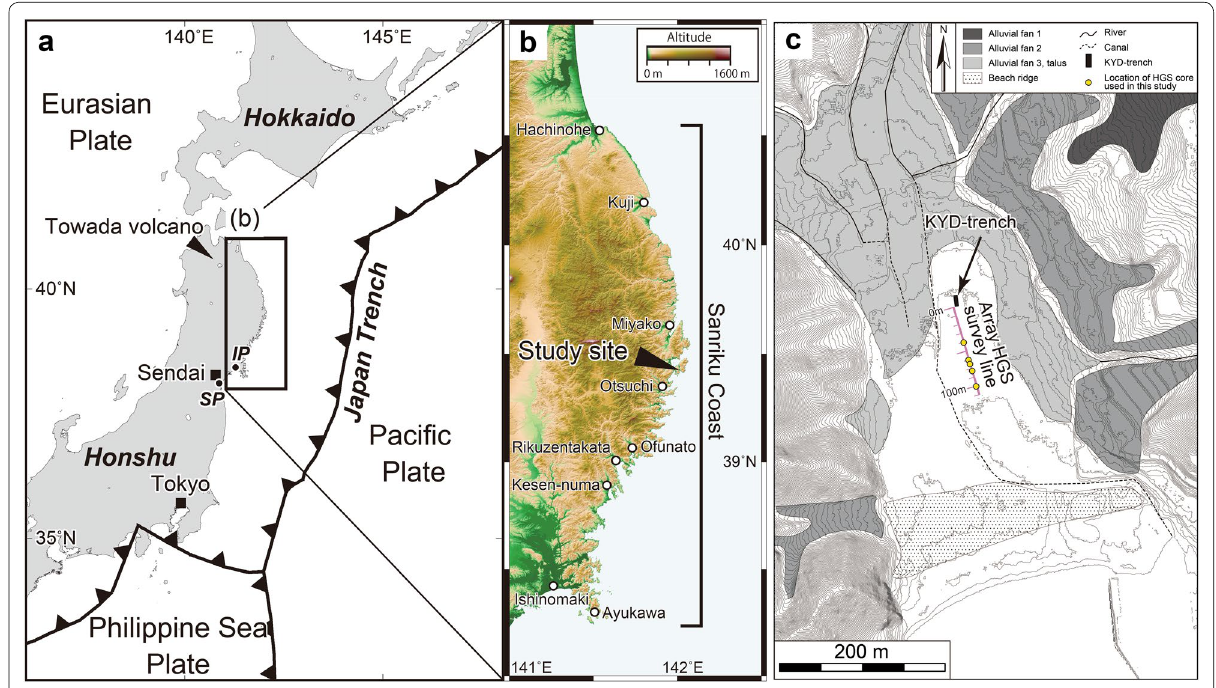
Fig. 1 Map of the study site. a Map showing the plate distribution and epicenter ( star ) of the 2011 Tohoku-oki earthquake. SP Sendai Plain, IP Ishinomaki Plain. b Color map of the Sanriku Coast. c Contour map of the study site with a geomorphic classification modified after Ishimura and Miyauchi (2015). The contour map is based on the 1-m mesh DEM supplied by the Iwate Prefecture. The contour interval is 1